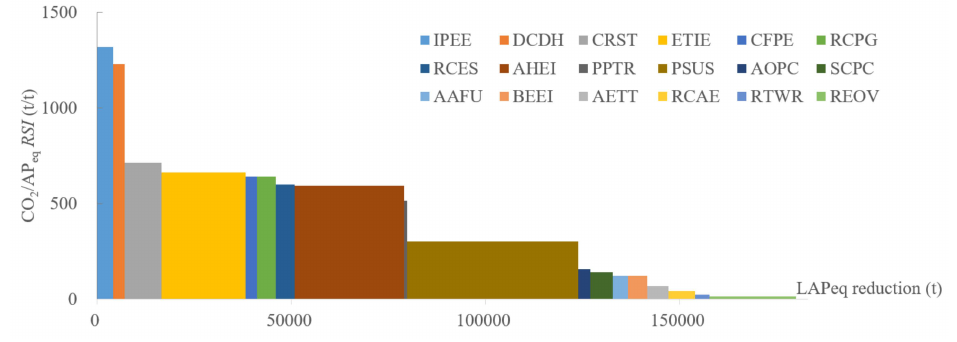
Figure 14. SRC of AP eq and CO 2 emissions in